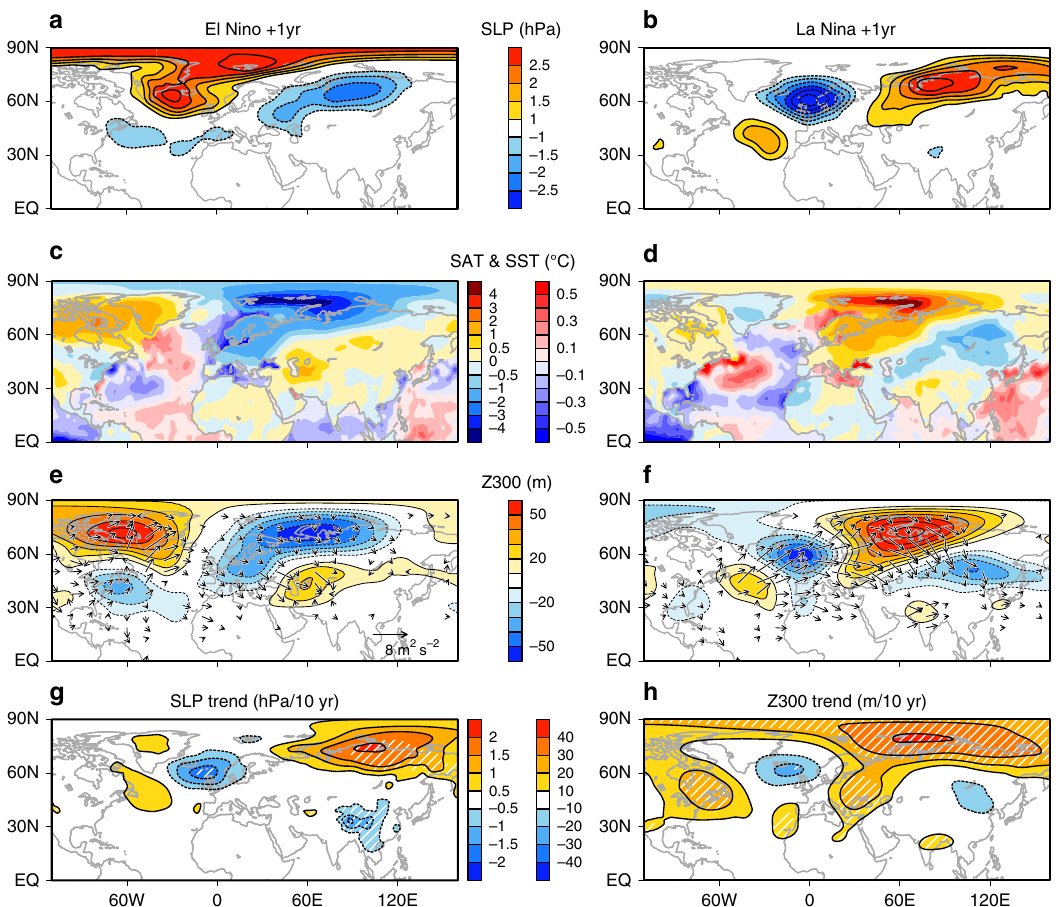
Fig. 5 Composite mean differences in El Niño and La Niña decay-years and recent trends. Composite mean differences between El Niño-decay years (1992, 1995, 1998, 2003 and 2010) and climatology (1990 – 2015) in a sea level pressure (SLP), c surface air temperature (SAT), and sea surface temperature (SST), and e 300-hPa geopotential height (Z300) (shading). b , d and f As in a , c and e , respectively, but for La Niña-decay years (1999, 2000, 2008, 2011 and 2012). Vectors in e , f show the associated wave activity fl ux. Linear trend of g SLP (hPa decade − 1 ) and h Z300 (m decade – 1 ) from 1987 to 2015 (Hatching: p < 0.05